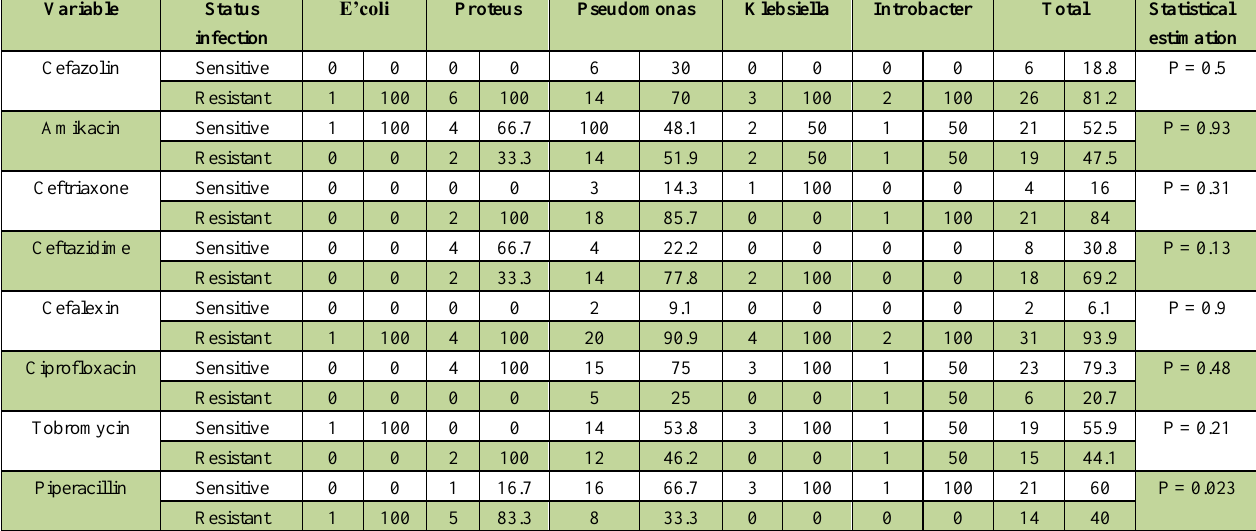
Table 11. Antibiogram Response Pattern to Different Types of Bacterial Agents Cultivated in Patients Admitted to ICU at the Time of Admission in Sep 2104-